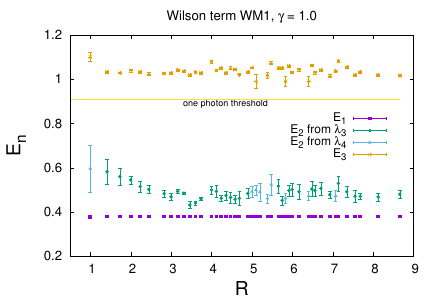
Figure 6. Ground and excitation energies of static fermions in the chiral gauge model at β = 3 ,γ = 1, shown together with the threshold for creation of a massive photon above the ground state